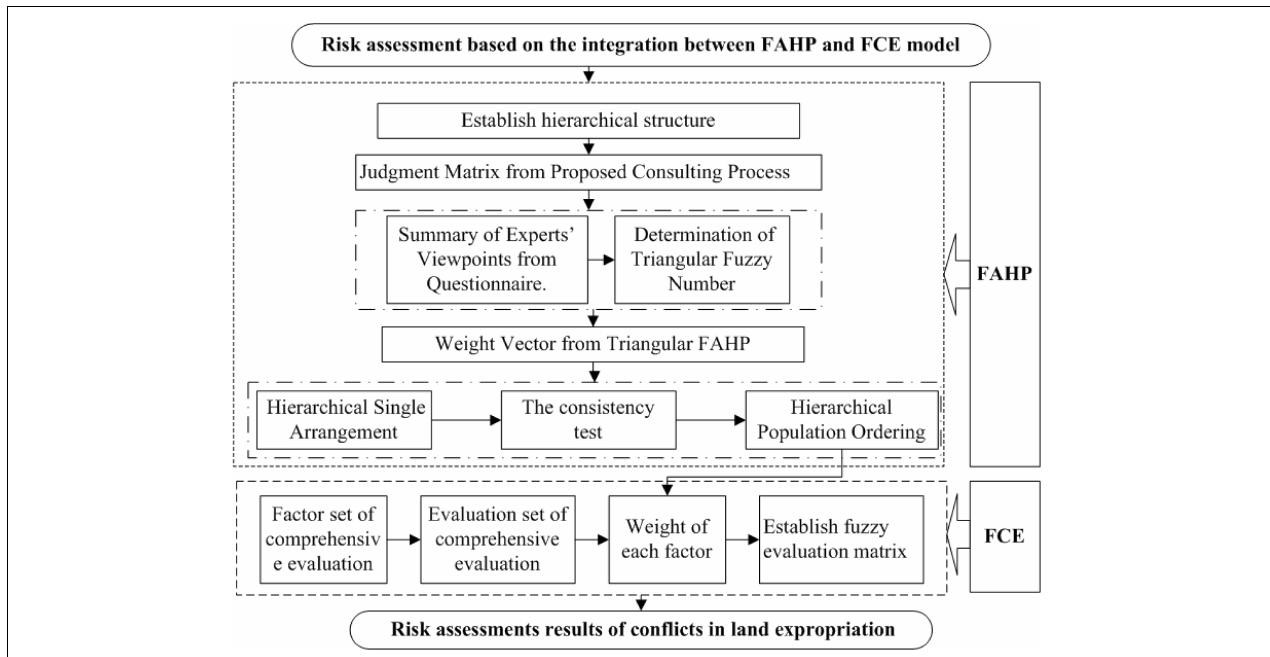
FIGURE 3 | Flow pipe of the risk assessment using